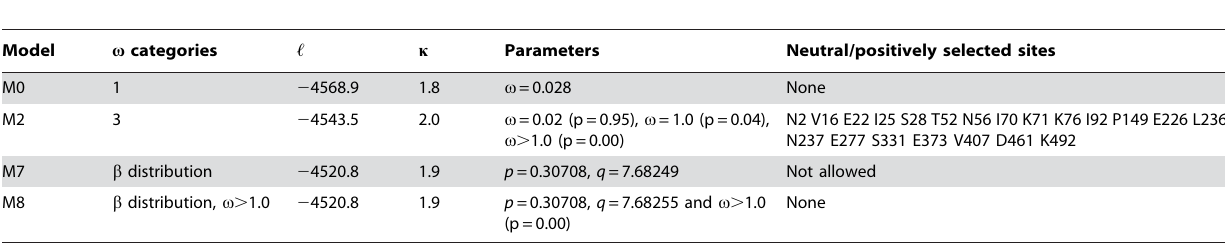
Table 1. Parameter estimates, log-likelihood values and selective pressures across codons for P. falciparum glycerol kinase under models of variable v